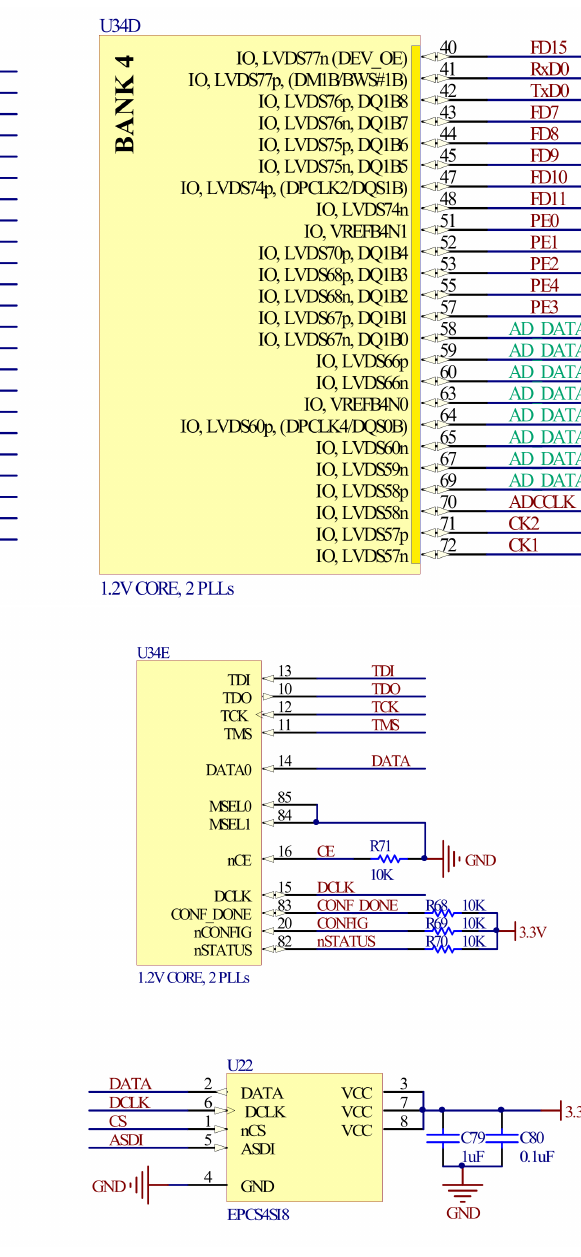
Figure 12. FPGA main control